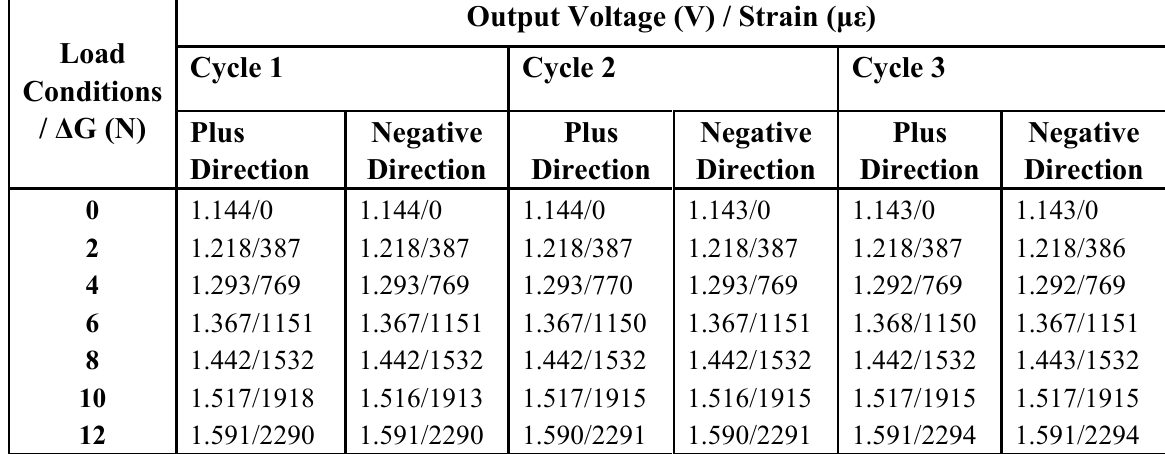
Table 1. Experimental data of the sensor node by repetitive